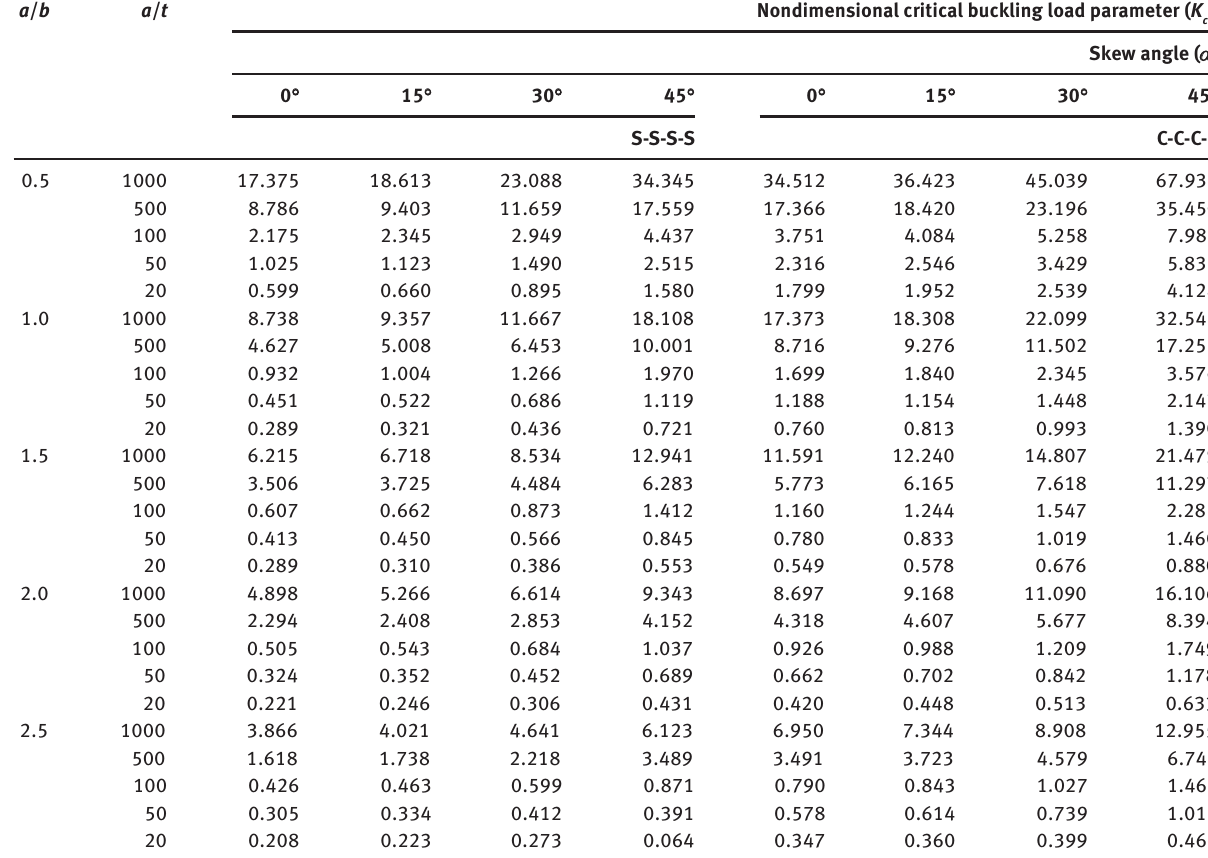
Table 3 Nondimensional critical buckling load parameter for isotropic cylindrical skew panels (Ø = 15 °